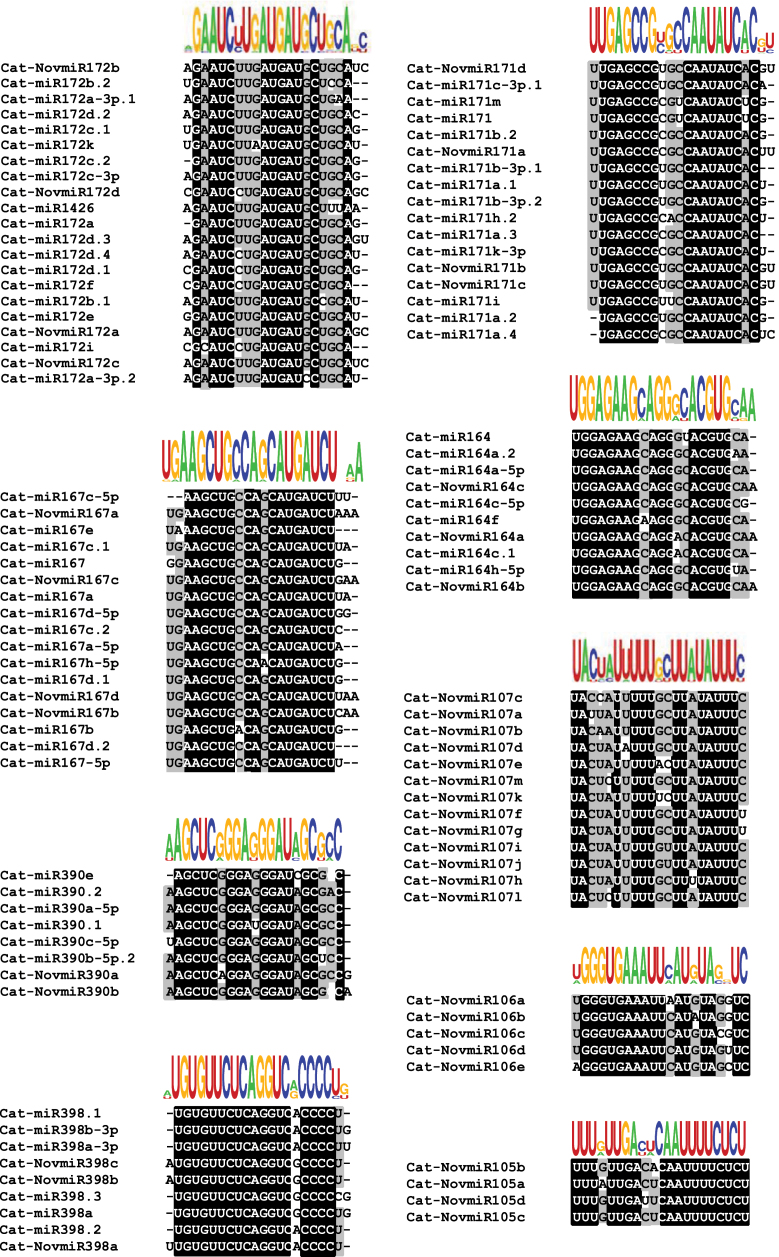
Clustering of conserved and novel miRNAs into families. Representative diagram showing the members of both conserved and novel miRNA families. The sequence alignment along with the consensus sequence logo of each family is shown. The nucleotides conserved in all the miRNAs of the same family are highlighted in black and those conserved in at least 50% of aligned sequences are highlighted in grey. This figure is available in colour at JXB online.